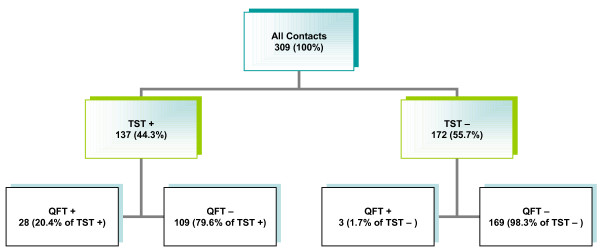
Application of the QFT-G test in a population of close contacts